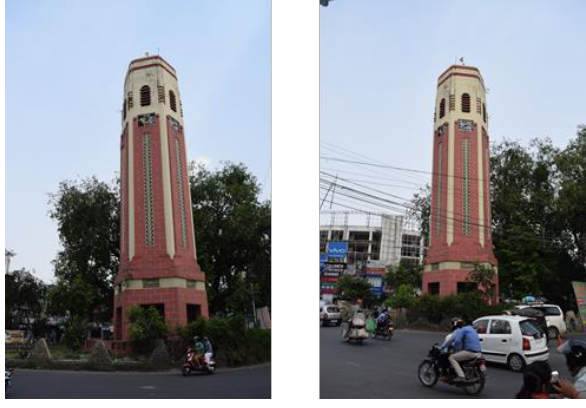
Figure 1: Clock Tower, Dehradun